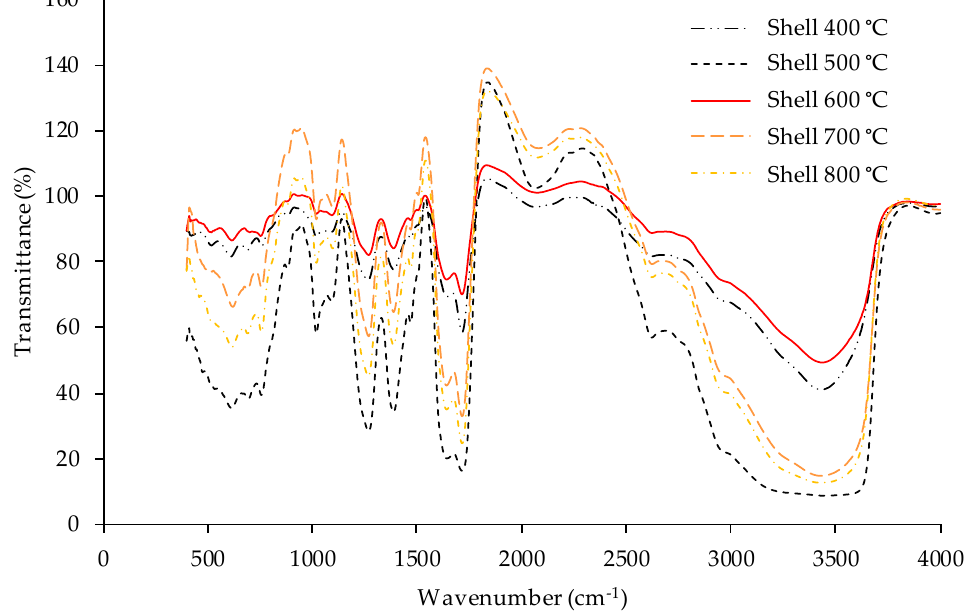
Figure 6. Fourier transform infrared spectroscopy (FTIR) spectra of waste coconut shell bio-oil at different temperatures.